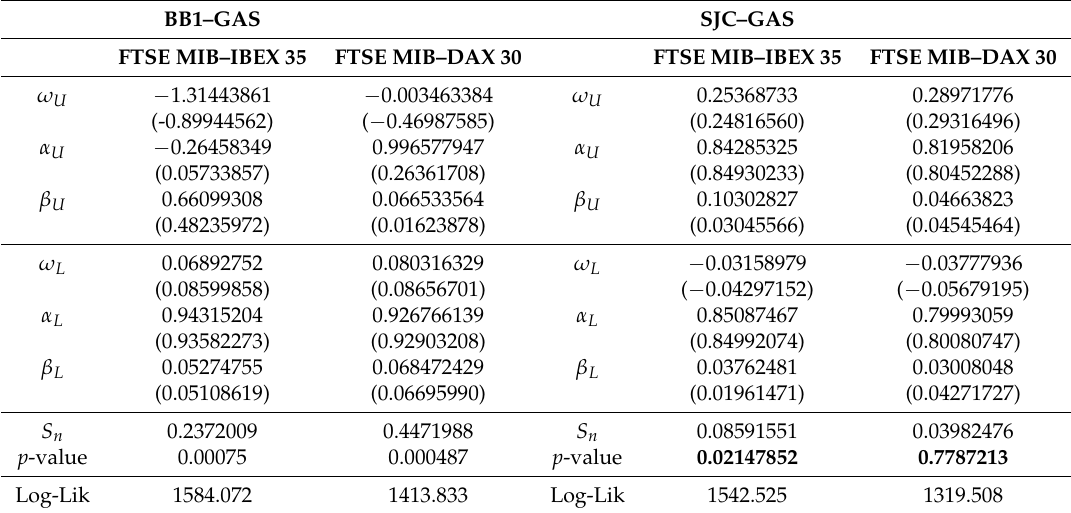
Table 5. Fitted coefficients, Cramér–von Mises t.s., and log-likelihood for the BB1, and for the SJC copulas with generalized autoregressive score model (GAS) dynamic as in Equation